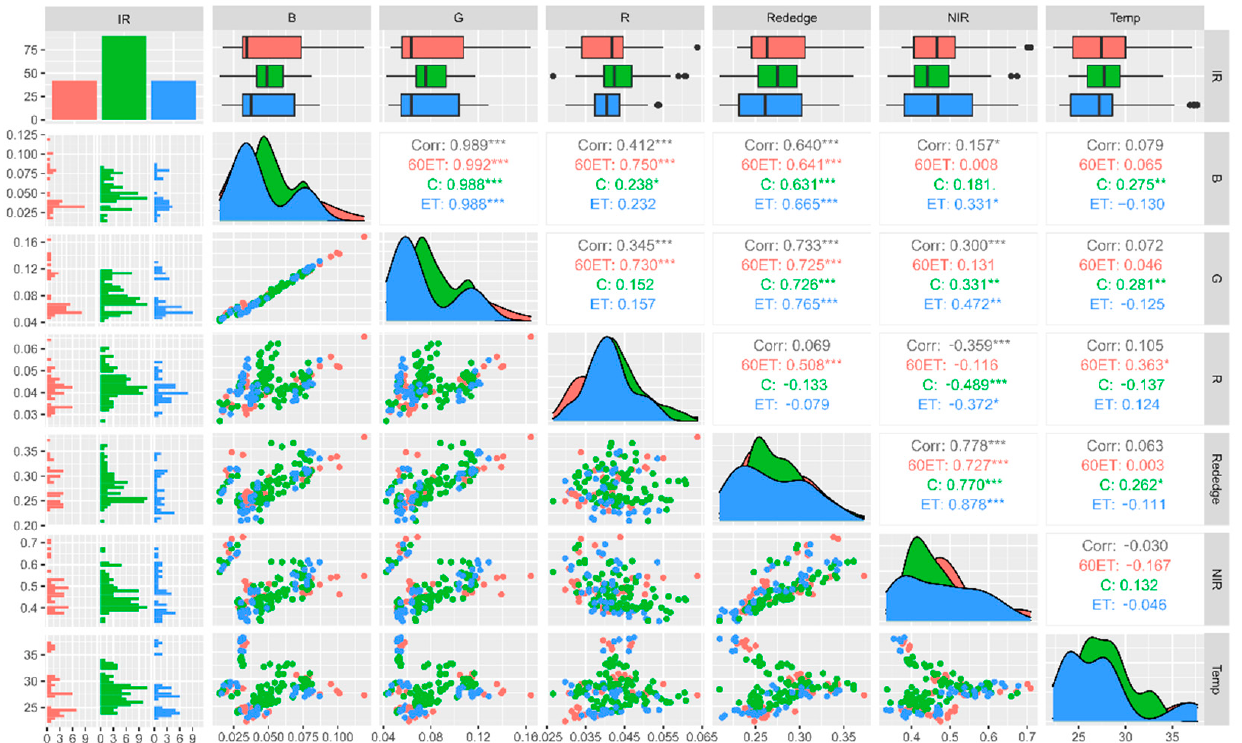
Figure 2. Pearson correlation analysis between the variables grain yield, temperature, spectral bands, and vegetation indices. The values shown in black indicate the overall correlation, while the colored values indicate the correlation between irrigation management. *, ** and ***: significant at 5, 1 and 0.1% probability by t-test, respectively.